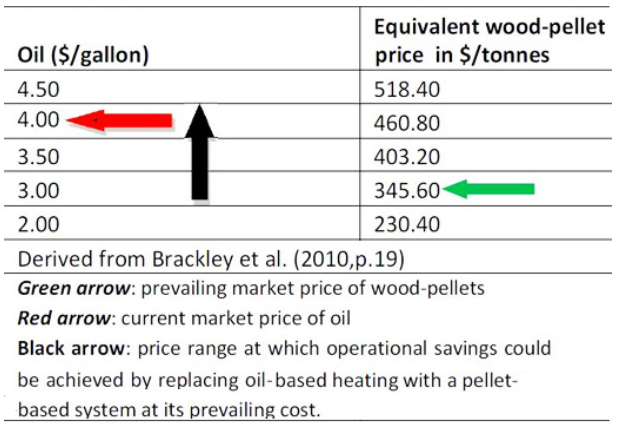
Fig. 3 . Oil-wood pellets price comparisons based on amount of energy